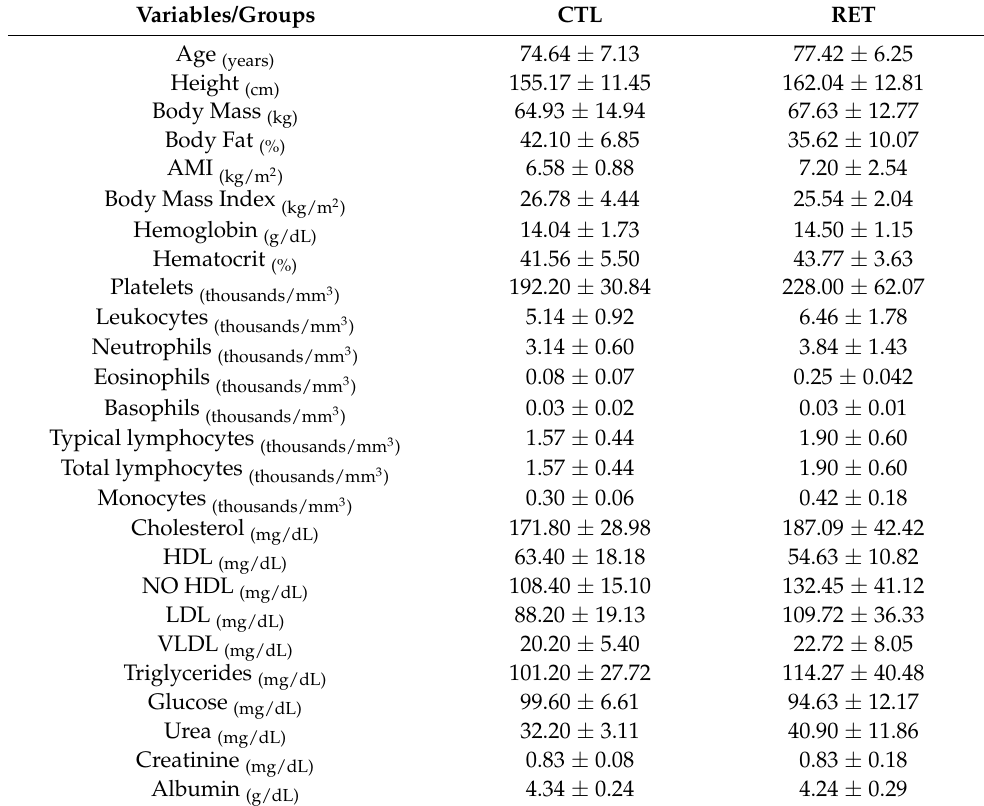
Table 1. Sample characterization at